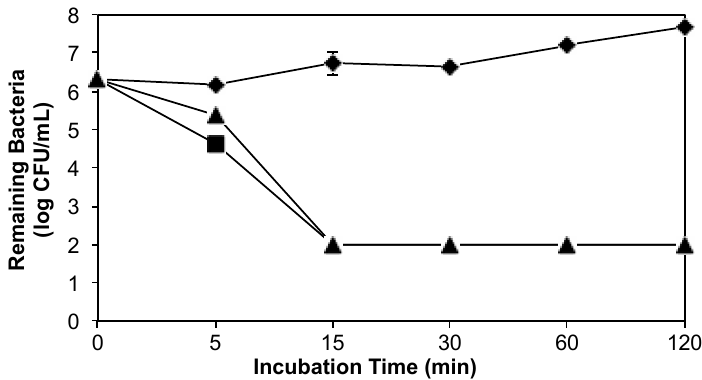
Figure 4. Kinetic antibacterial activity against P. aeruginosa of CSA-131 (100 µg/mL) (black squares), CSA-131 (100 µg/mL) with pluronic (4%) (black triangles); untreated control (black diamonds). Detection limit was two logs.